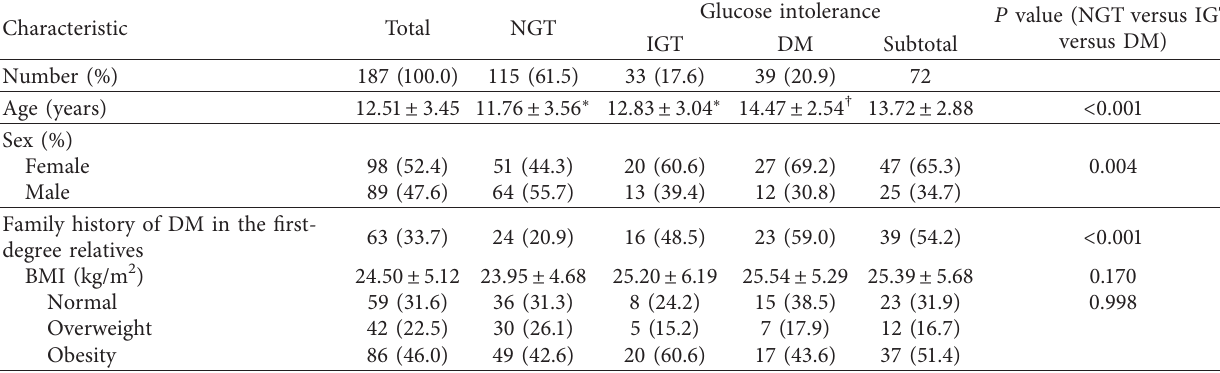
Table 1: Demographic features of the study